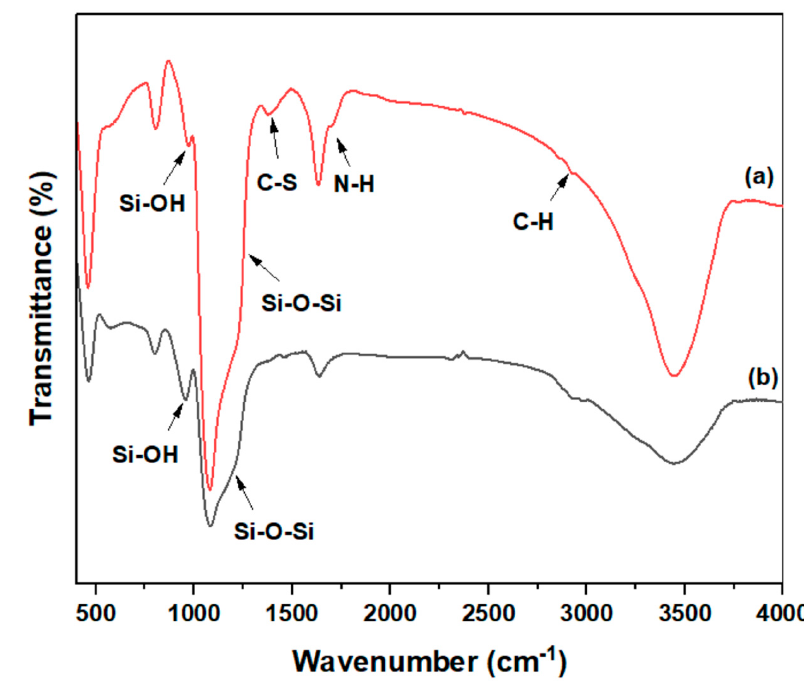
Figure 1. FTIR spectra of the ( a ) MSH@MA NPs; ( b ) MSNs.